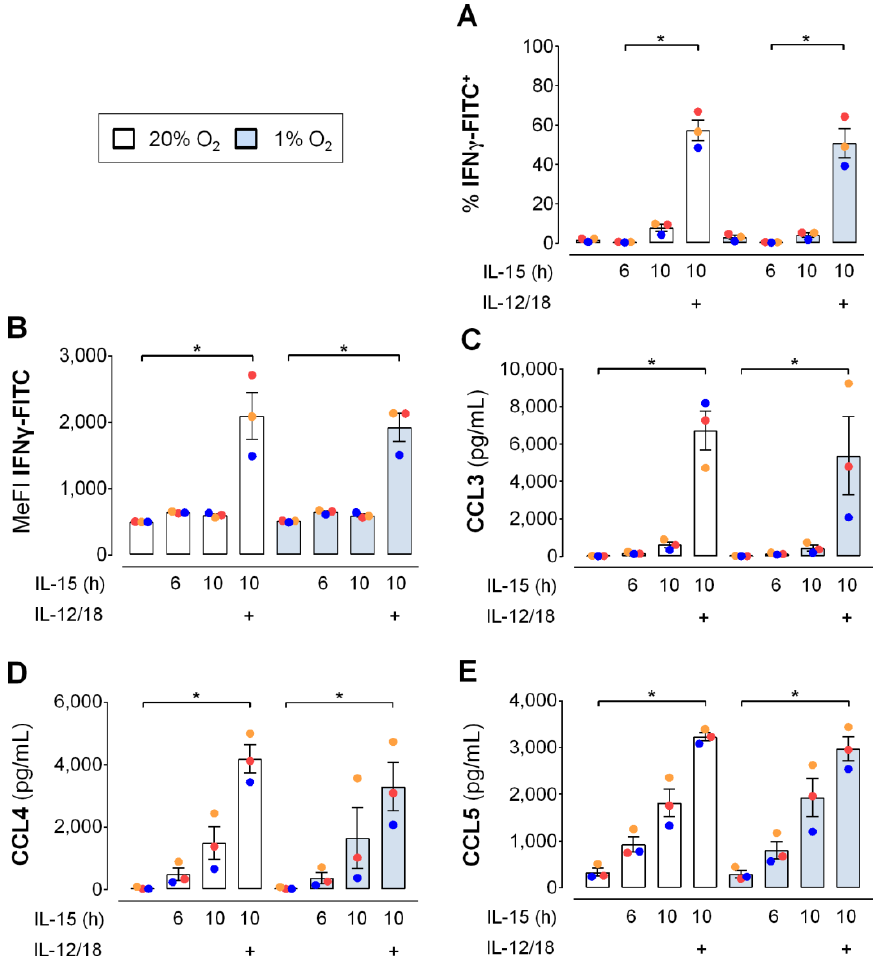
Figure 8. Hypoxia does not affect early IFN γ production and CC chemokine release by IL-15 primed human NK cells in response to IL-12/IL-18. NK cells from 3 buffy coats were seeded and cultured in parallel under normoxia (20% O 2 , open bars) and hypoxia (1% O 2 , blue bars). IL-15 was added at 16 h and IL-12 and IL-18 (IL-12/18) at 22 h. Cells and supernatants were collected at either 22 h (6 h IL-15 only) or at 26 h (untreated controls and 10 h IL-15 with or without 4 h IL-12/18) and analyzed for ( A , B ) cellular IFN γ production and levels of secreted ( C ) CCL3, ( D ) CCL4 and ( E ) CCL5. Data is shown as mean values ± SEM (bars) and scatter plots in a color scheme to identify data from independent experiments. Within the normoxia and hypoxia group each, statistical significance of mean differences was determined with the Friedman test with Dunn’s test for post-hoc pairwise comparisons. * p < 0.05. Corresponding treatments under normoxia and hypoxia were compared with the Wilcoxon signed-rank test but none reached the level of statistical significance.